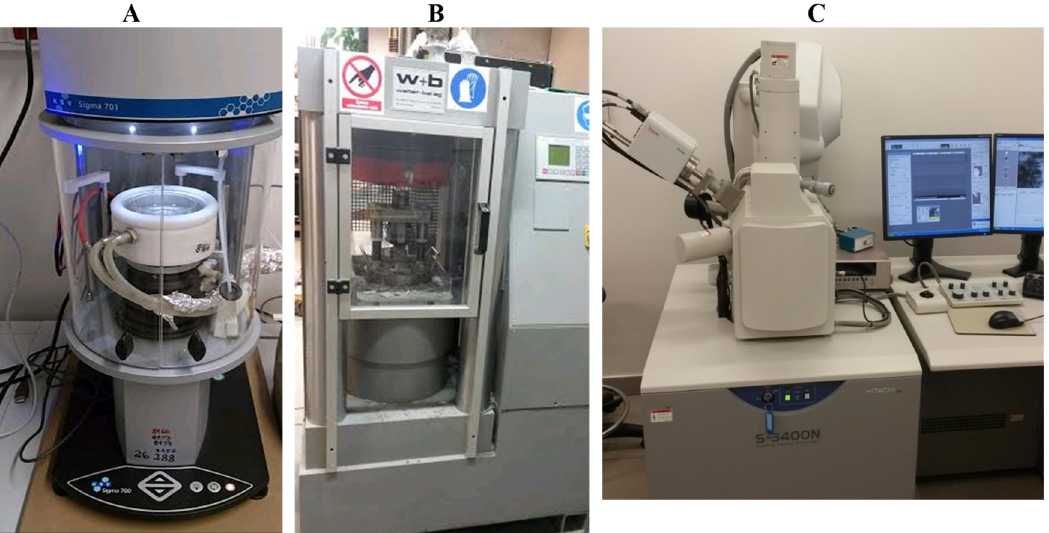
Figure 2. Pictures of the most-important equipment used in the study: ( A ) Sigma 701 tensiometer (KSV); ( B ) automatic press for testing concrete compressive strength (DIGICON 2000, Walter + Bai AG); ( C ) general view of the stand for sample analysis using SEM and EDS methods.